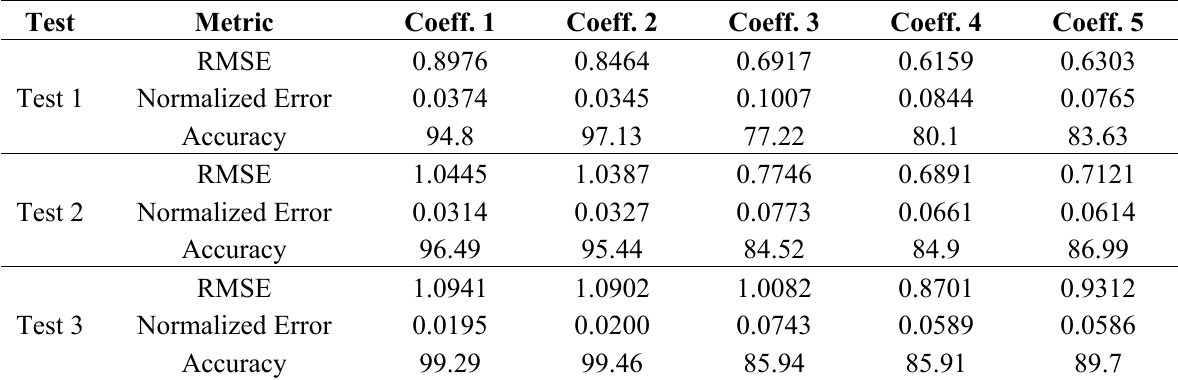
Table 3. Network performance metrics with test 1, 2 and